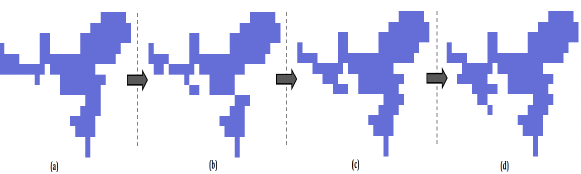
Figure 7. Change in spatial distribution of the Temperate climate zone (C) : (a) 1901-1925 , (b) 1926-1950 , (c) 1951-1975 , (d) 1976-